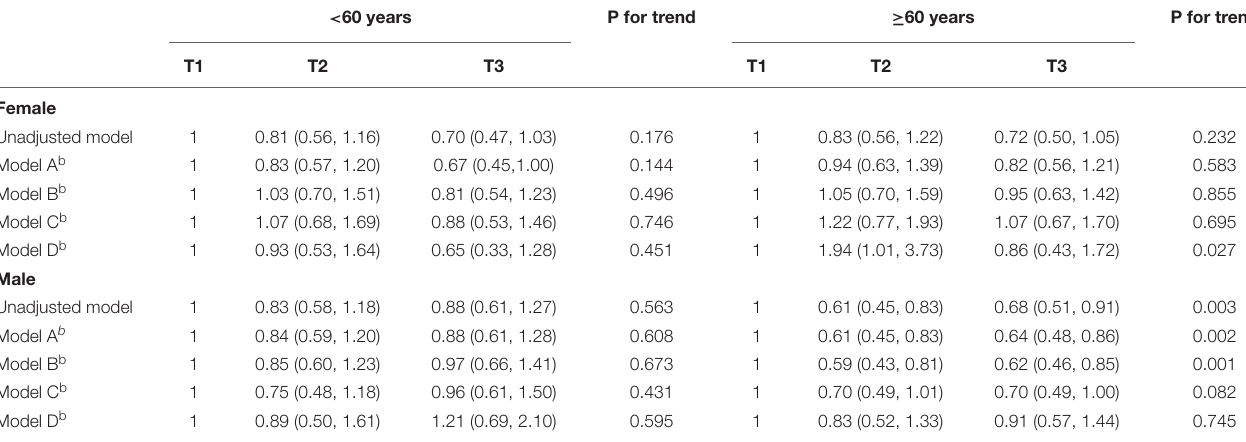
TABLE 3 | Association between the percentage of body fat and all-cause mortality using Cox proportional hazard regression.